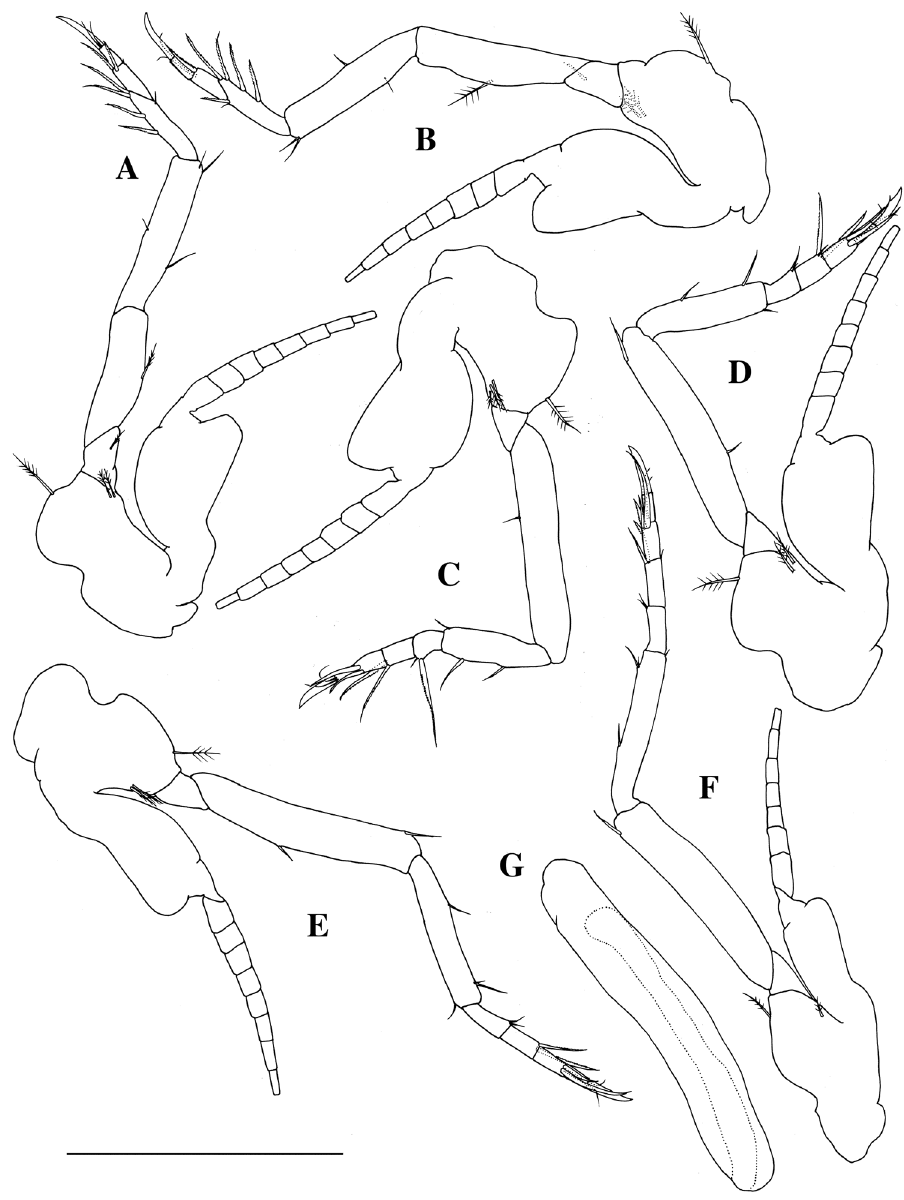
Figure 4. Mysidella hoshinoi sp. n., holotype male: A left third thoracopod, lateral B left fourth thoracopod C left fifth thoracopod, lateral D left sixth thoracopod, lateral E left seventh thoracopod, lateral F left eighth thoracopod, lateral G left penis, ventral. Scale bar: 500